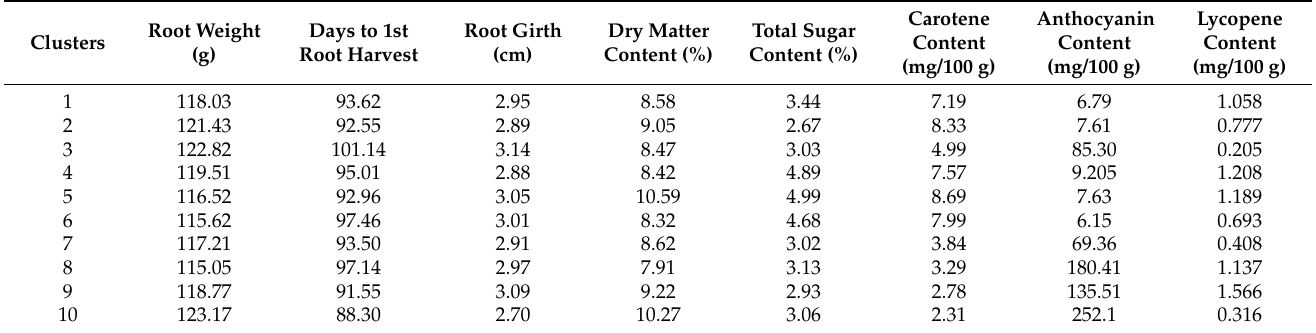
Table 3. Cluster means for different traits for 81 genotypes of carrot are shown in the table. Based on the average performance of the genotypes included in the cluster, cluster means for different characters were determined.